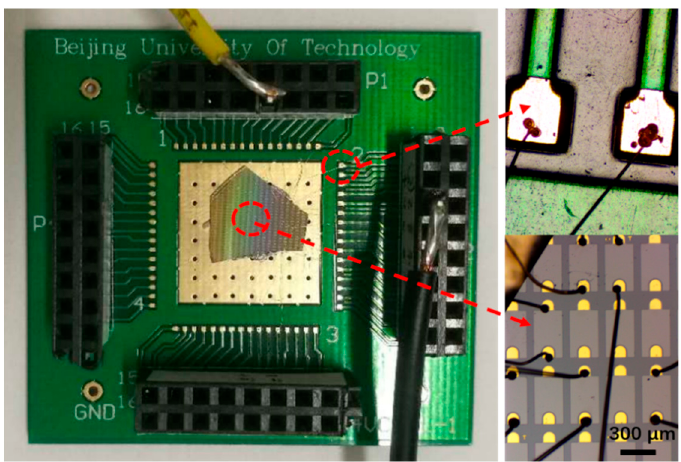
Figure 7. Wire bonding and packaging diagram of the LEDs for thermal measurement. The pentagon in the middle is the GaN piece which was diced to fit the measurement setup.